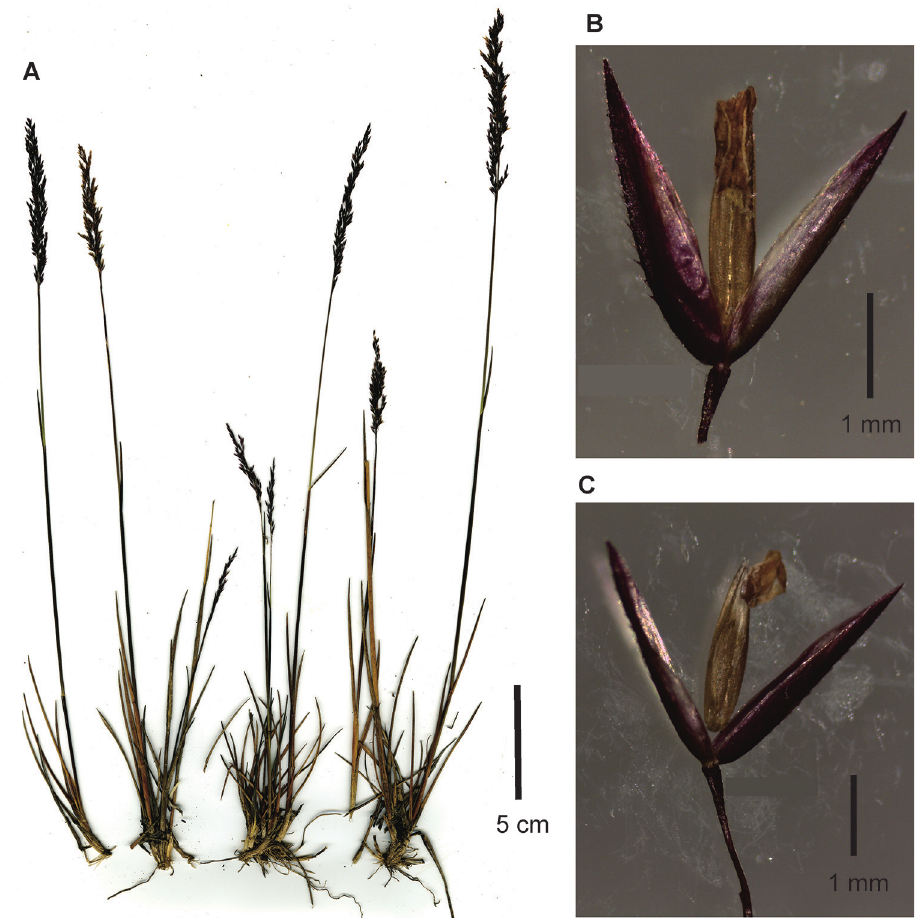
Figure 2. Agrostis boyacensis , example of a specimen encountered in páramos of Boyacá outside of the Sierra Nevada del Cocuy A whole plant B spikelet, glumes lateral view and floret ventral view showing anthers C spikelet, glumes lateral view with floret detached and raised above the glumes showing ventral surface. Images of Sylvester 3017a